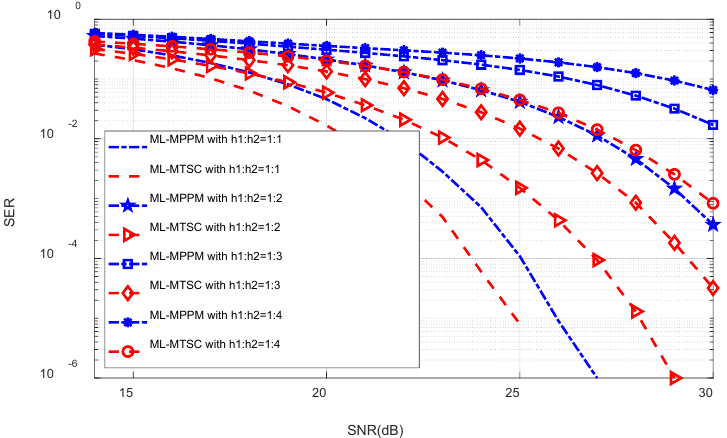
Figure 5. Error performance of the ML-MTSC scheme and the TDMA&ML-MPPM scheme. Here, we discuss the influence of LED wick number on SER performance, and give the change in symbol error rate relative to SNR when N = 2, h 1 : h 2 = 1 : 1, as shown in Figure 6. With the increase in the number of LED cores, the error performance becomes worse. This is because the modulation level of multi-level symbols used in coding is determined by l max . With the increase in the order of codewords, the Euclidean distance between codewords becomes smaller, and the error performance in receiving and detecting will increase accordingly.